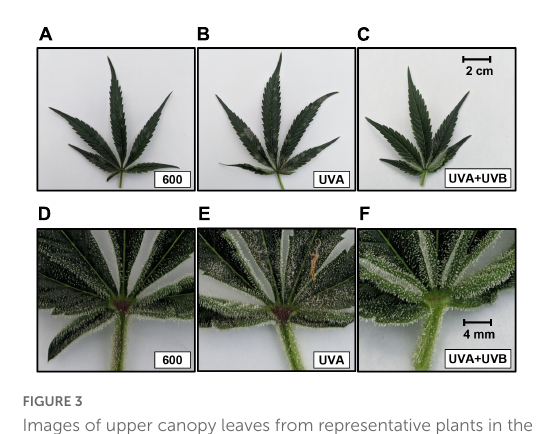
FIGURE3 Images of upper canopy leaves from representative plants in the 600 µ mol m − 2 s − 1 (control) (A,D) , UVA (B,E) , and UVA + UVB (C,F) treatments. The images in the upper row are entire leaves. The scale bar in the upper right corner of 3c is 2.0 cm and is the same size for all images in the upper row. The images in the lower row are 5 × magnifications of the foliar portions proximate to the petiole of the respective upper row images. The scale bar in the upper right corner of 3f is 4 mm and is the same size for all images in the lower